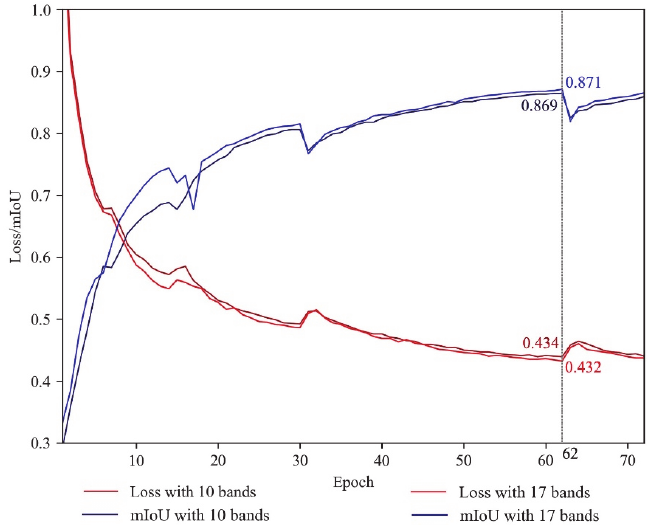
Figure 4. Training parameter results of the two schemes with upsampling of small samples.